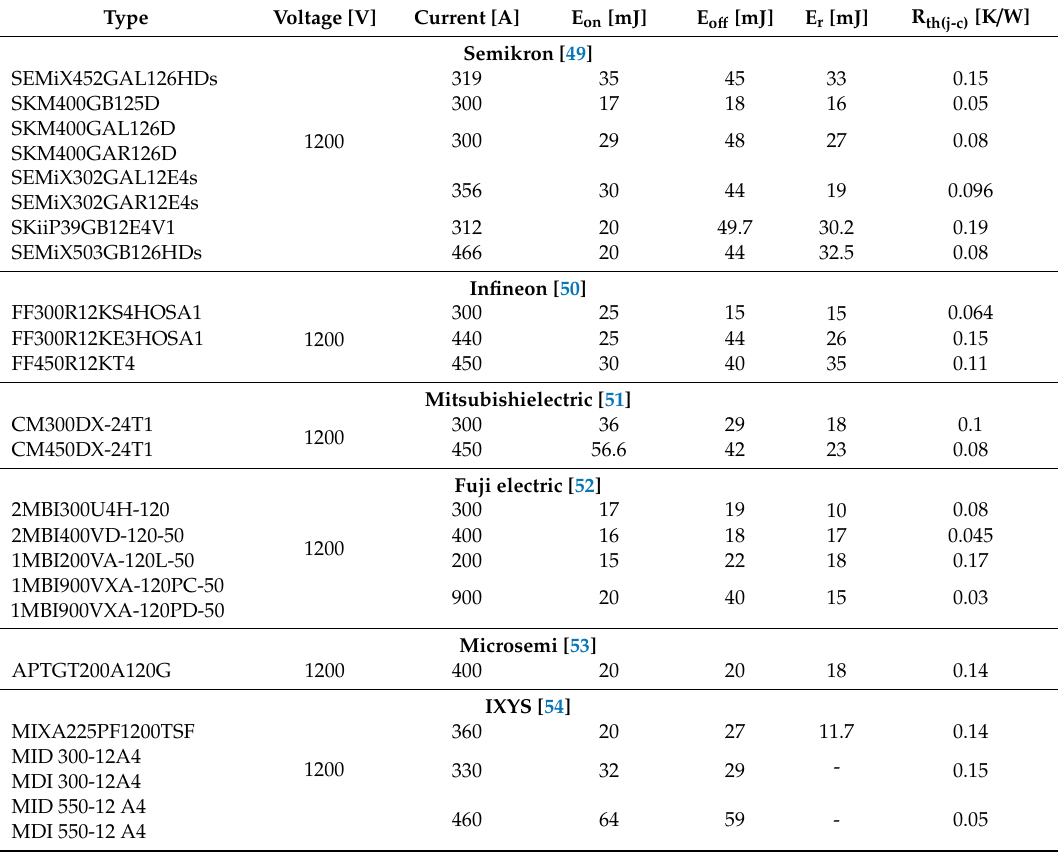
Table A1. IGBT modules, suitable for the proposed